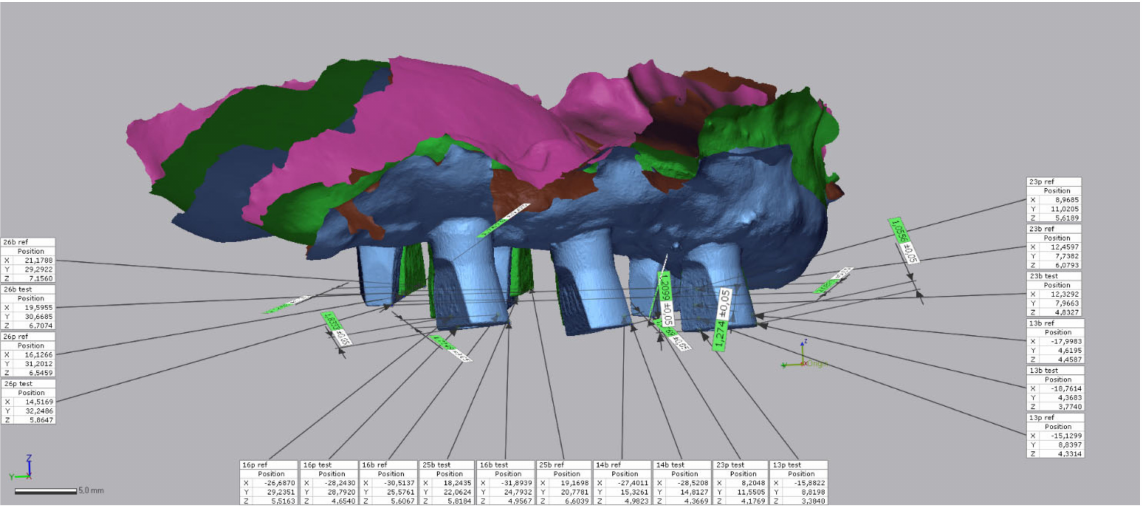
Figure 12. For each patient, 10 analytical points were added to different scan body positions in the maxillary arch. Numerical identification of each analytical point was performed along the X-, Y- and Z -axes (Geomagic Control X, 3D Systems Inc., Rock Hill, SC,